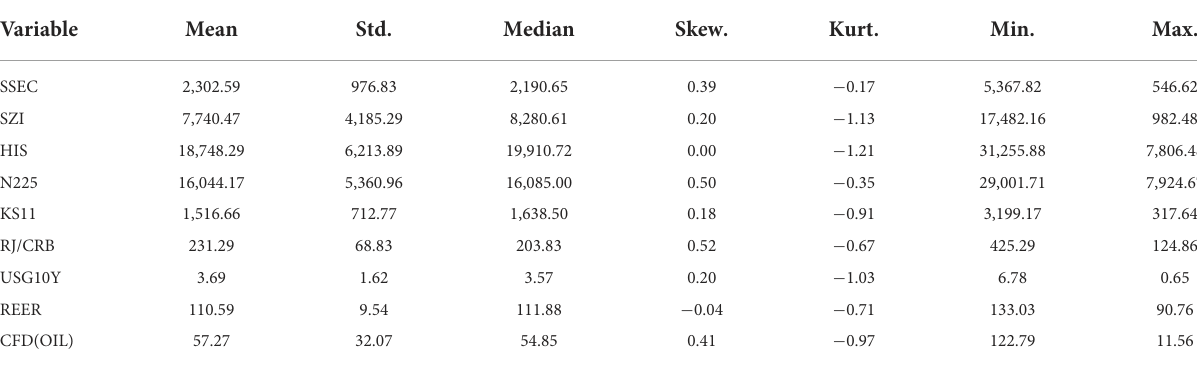
TABLE 1 Statistical description of the main variables in the